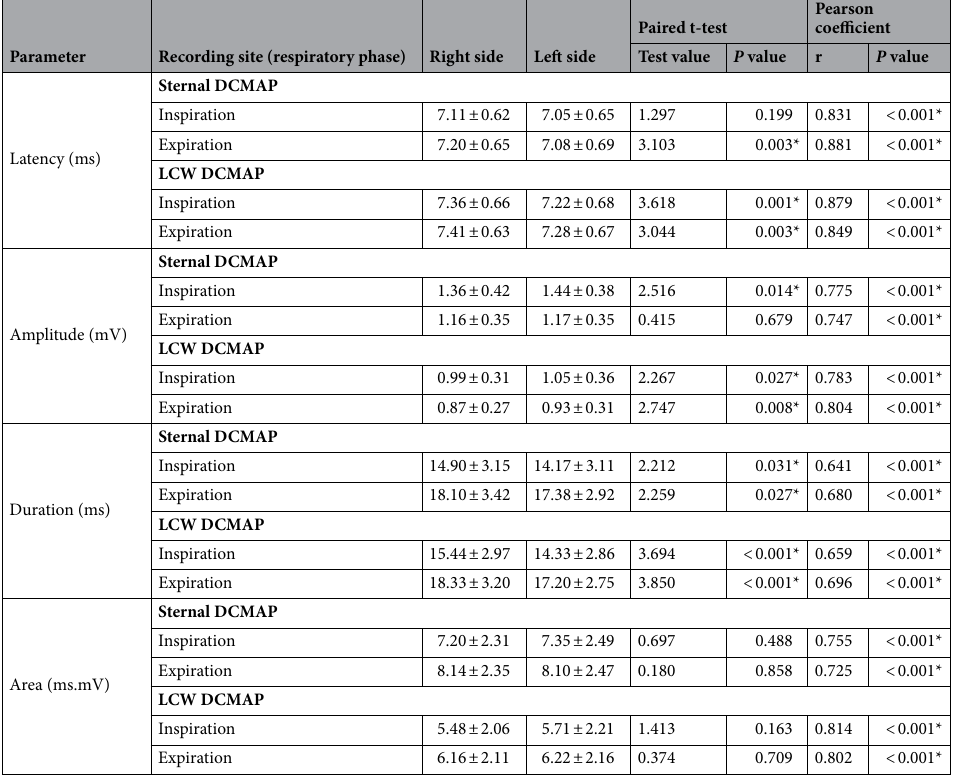
Table 2. Comparison between right and left DCMAPs recorded from over the sternum and LCW during inspiration and